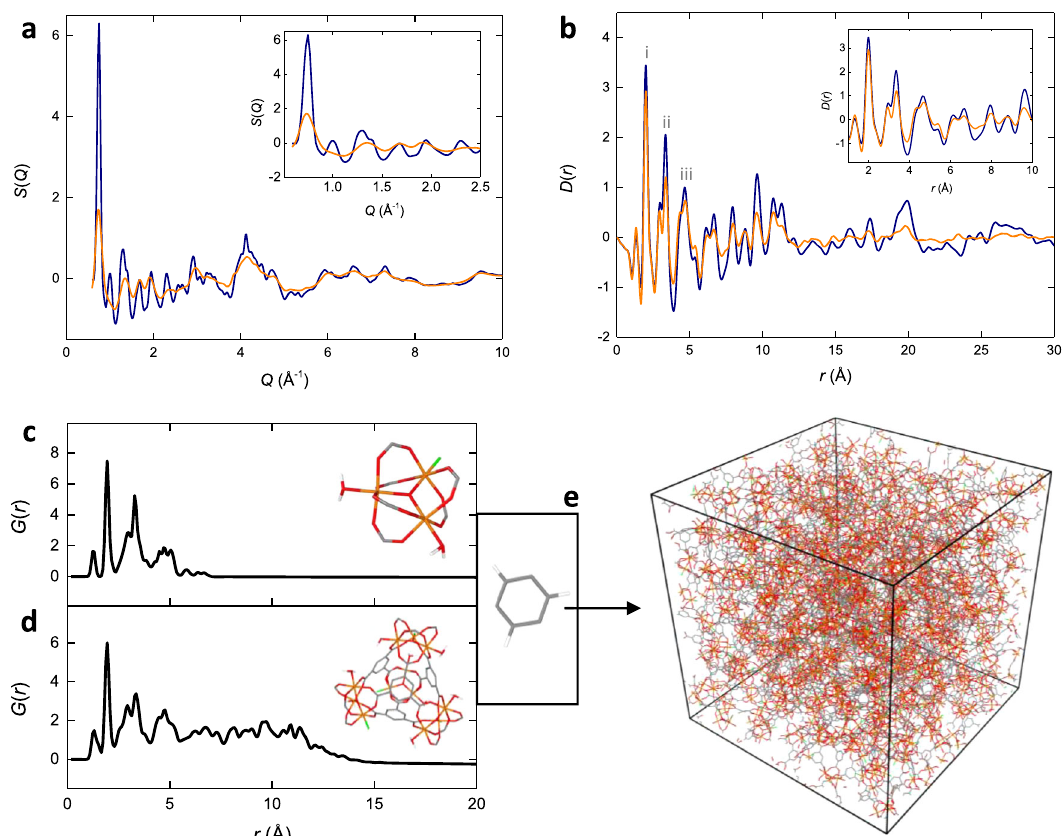
Fig. 2 Pair distribution function analysis. a X-ray structure factor for MIL-100 (blue) and Fe-BTC (orange), inset shows the low- Q region. Total scattering data on MIL-100 reproduced from ref. 34 . b X-ray PDF for MIL-100 (blue) and Fe-BTC (orange), obtained via the Fourier transform of the data in ( a ). Inset shows low- r region. c Calculated PDF for a single trimer unit, structure shown inset. d Calculated PDF for a single tetrahedral assembly, structure shown inset. e An amorphous model is obtained following the polymerisation of the metal nodes and linker, saturation and annealing steps. Hydrogens have been